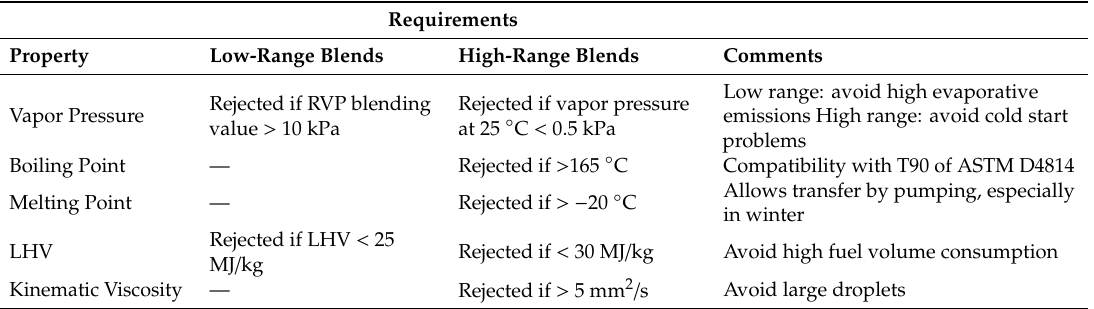
Table 2. Property values used for screening in the two scenarios. The RVP blending value is the di ff erence between the measured or predicted RVP of the blend (weighted average) and that of base gasoline. “—” indicates that the criterion was not applied for the indicated